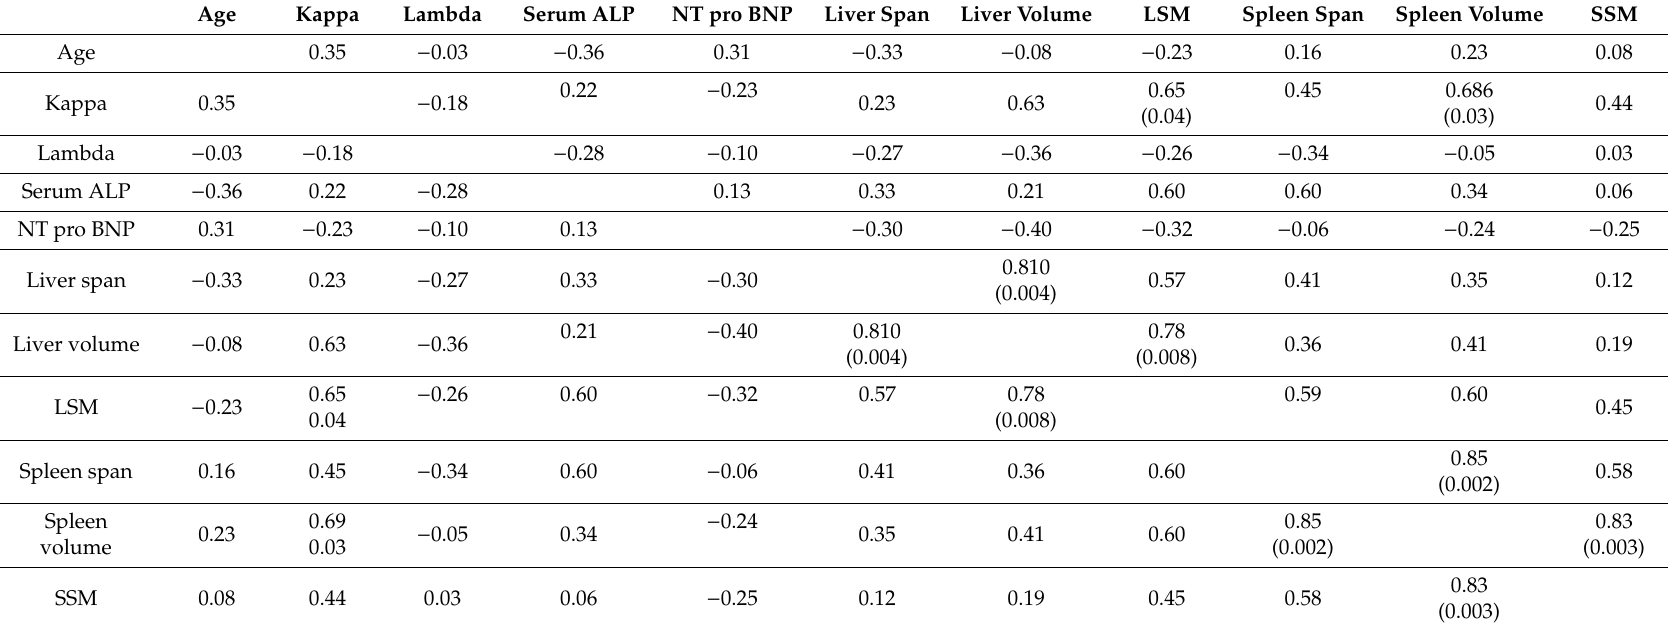
Table 2. Pearson correlation coe ffi cients between multiple variables